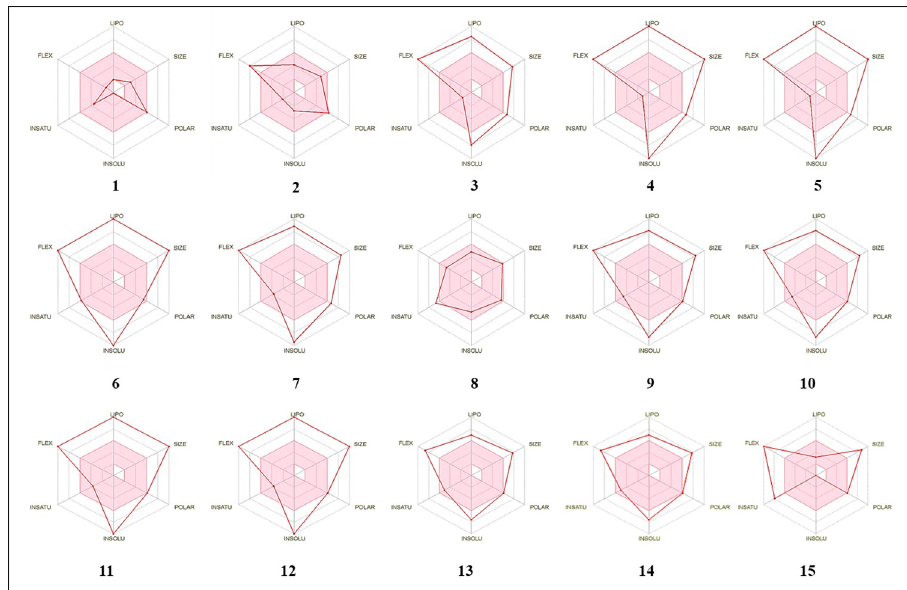
Fig 9. Bioactivity radar. Charts of the cytidine derivatives where FLEX: Flexibility, LIPO: Lipophilicity, INSATU: Unsaturation. and INSOLU: Insolubility.